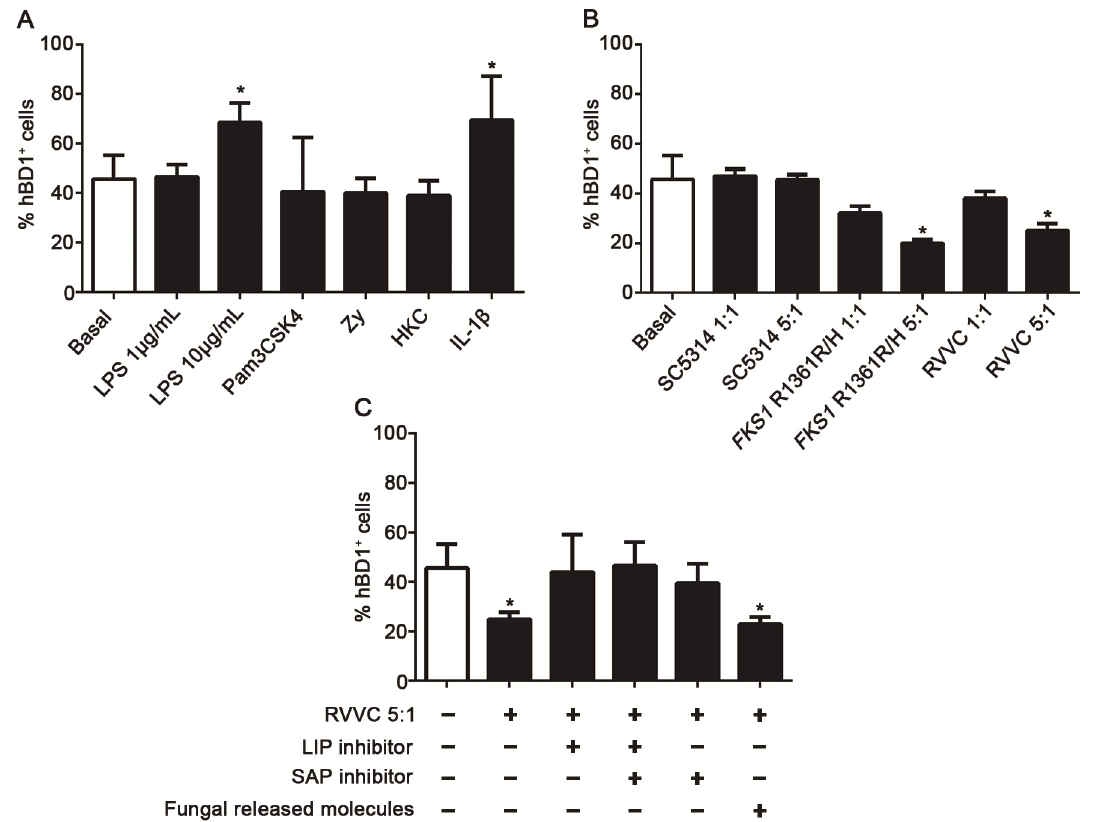
Figure 6. Regulation of human Beta Defensin-1 (hBD1) in epithelial cells of female genital tract. ( A ) Percentage of hBD1 positive HeLa cells incubated for 4 h without stimuli (basal) or with LPS (1 µ g/mL or 10 µ g/mL), Pam3CK4 100 ng/mL, IL-1 β 10 ng/mL, HKC 1:1 ratio, or Zymosan 20 µ g/mL, determined by flow cytometry. Data are representative of three inde- pendent experiments. Mean ± SEM. * p < 0.05 compared to basal expression. ( B ) Percentage of hBD1-positive HeLa cells incubated 4 h without stimuli (basal) or with different C. albicans strains ( C. albicans SC5314, C. albicans FKS1 R1361R/H , and C. albicans isolated from an RVVC patient) at 1:1 or 5:1 ratio. Data are representative of three independent experiments. Mean ± SEM.* p < 0.05 compared to basal expression. ( C ) Percentage of hBD1-producing cells after 4 h of transwell system culture without stimuli (basal) or with C. albicans RVVC at a 5:1 ratio; C. albicans RVVC at a 5:1 ratio together with a SAP inhibitor Pepstatin (1 μ g/mL) or the LIP inhibitor ASA (625 μ M) and with both inhibitors. Data are representative of three independent experiments. Mean ± SEM.* p < 0.05 compared to basal. ANOVA test. 4. Discussion BDs are an important alarmin family within the AMPs molecules involved in the protection against pathogens in mucosal tracts [10,12,13]. Despite these properties, studies on their roles during C. albicans vaginal infection in animal models and especially in pa- tients with the acute or recurrent form of the mycosis are limited. Using a murine AVVC model, we described the kinetic response of mBD1 expression in the vaginal tract during C. albicans ATCC-36801 infection. The number of mBD1+ cells in the lumen at D2 pi was significantly increased, and mBD1+ protein expression was observed in resident cells and recruited PMNs. These results were confirmed in an in vivo infection model using a C. albicans strain isolated from RVVC. We found that the fungal load and intravaginal level of IL-1 β remained high, mBD1+ cells increased, and the percentage of Gr-1+ mBD1+ cells was nearly 2.8-fold higher than that found in C. albicans ATCC-36801-infected animals. These findings showed that, after acute exposition to C. albicans , constitutive mBD1 ex- pression was early increased and that this response was correlated with the infection se- verity. In line with this result, we had previously reported that lack of TLR2 receptor sig- naling [23], which predisposes mice to massive C. albicans invasion of the vaginal tract,